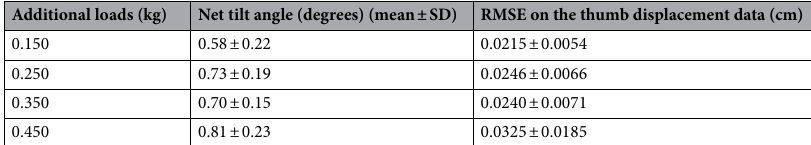
Table 1. Root Mean Square Error on the thumb displacement data and Net tilt angle. The table shows the average net tilt angle measured in degrees and root mean square error (RMSE) in cm on the thumb displacement data with standard deviation for the four different loads 0.150, 0.250, 0.350, and 0.450